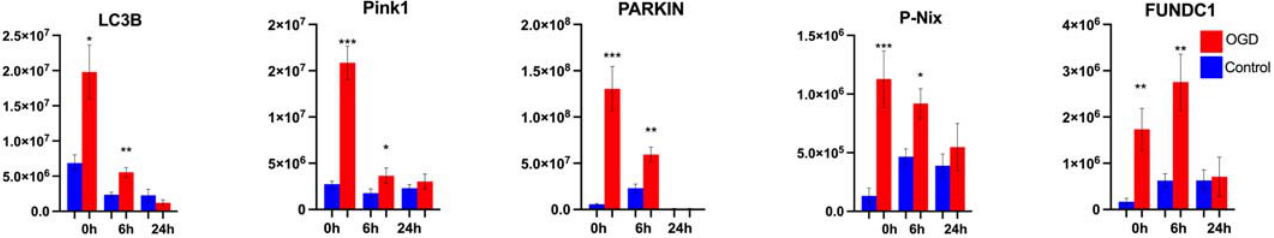
Figure 10. Quantification of mitophagy-related proteins after OGD in primary neurons, n = 6–8/gp +/ − SEM. * p ≤ 0.05, ** p ≤ 0.01, *** p ≤ 0.001. Statistics compared by Mann–Whitney Test with respec ‐ tive controls.